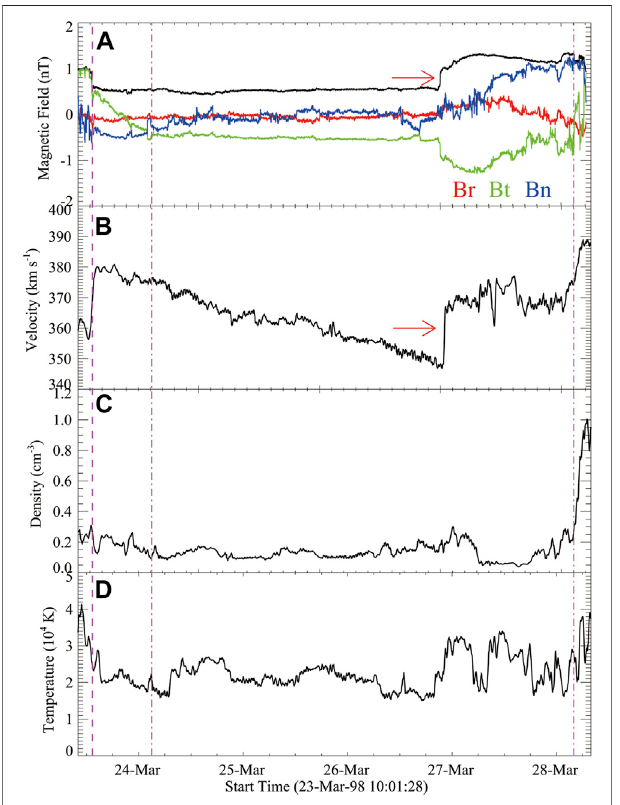
FIGURE 3 | Magnetic fi eld and solar wind parameters measured by Ulysses near 5.4 AU. (A) Total magnetic fi eld strength (black) and its three components in RTN coordinate and (B – D) velocity, density, and temperature of solar wind. The vertical dashed line denotes the shock, and the dash- dotted lines demarcate the MC boundaries. The red arrows in (A) and (B) depict the shock inside the MC.